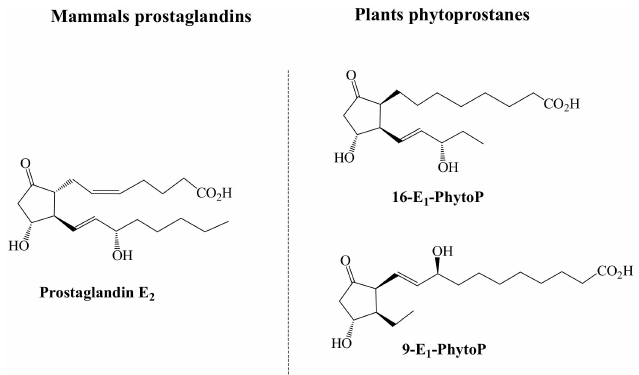
Figure 2. Chemical structure of PGE 2 and E 1 -PhytoP sharing the capacity to polarize the immune response to TH2 pro-allergenic.